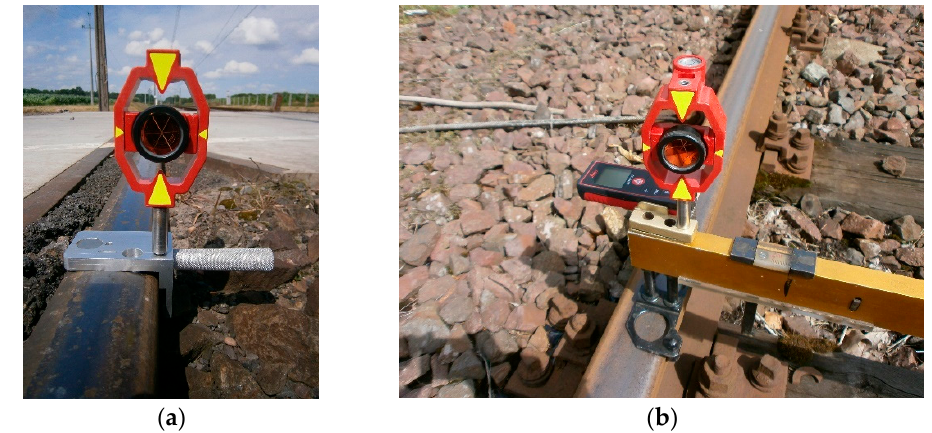
Figure 1. Integrated Geodetic Mini Prism Type 111 (GMP111) with: ( a ) magnetic measuring square (MMS); ( b ) gauge measure for measuring track and turnout parameters (GM) and laser distance meter (LDM).